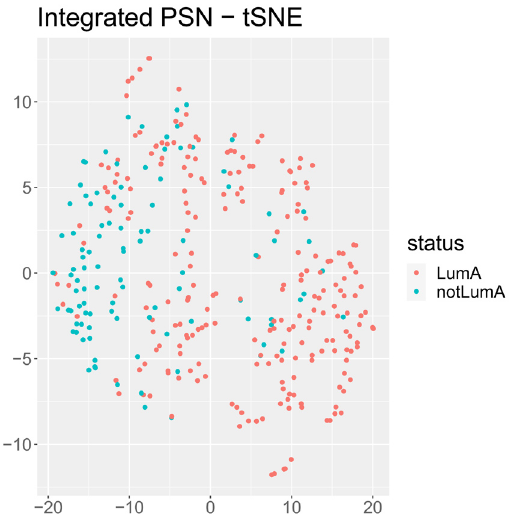
Figure 8. tSNE plot of integrated patient similarity network based on features passing selection.